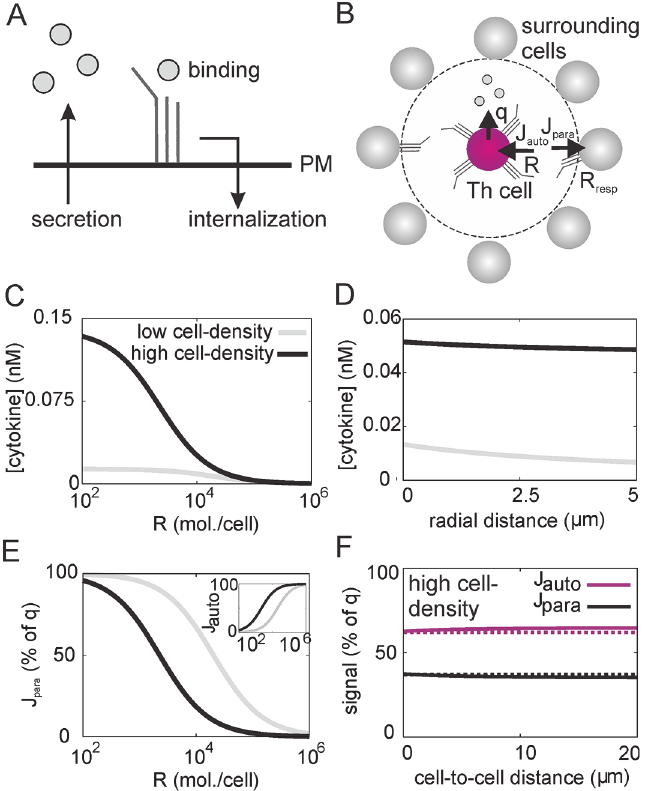
Fig 1. Paracrine cytokine signals depend on cell density and receptor number. (A) Cytokine secretion and uptake is followed by receptor internalization, leading to a reduced cytokine concentration in the medium. (B) Schematic of the high cell-density scenario. A cytokine secreting cell is surrounded by a layer of responder cells that provide a diffusion barrier for the cytokine. Signaling can be autocrine (J auto ), i.e. cytokine molecules are bound by receptors of the cytokine secreting cell, or paracrine (J para ), i.e. bound by receptors on responder cells. (C) Cytokine concentration profile in the model with homogeneous secretion and uptake. (D) Cytokine concentration 1 μ m away from the cytokine secreting cell, in the limits of high and low cell- density. (E) Paracrine signal J para and autocrine signal J auto (inset) as fraction of secreted cytokine molecules. (F) Autocrine and paracrine uptake in the high cell-density scenario. Dotted lines are approximations in the limit of fast diffusion (see S1 Text). Parameter values: R = 4000 mol./cell, and